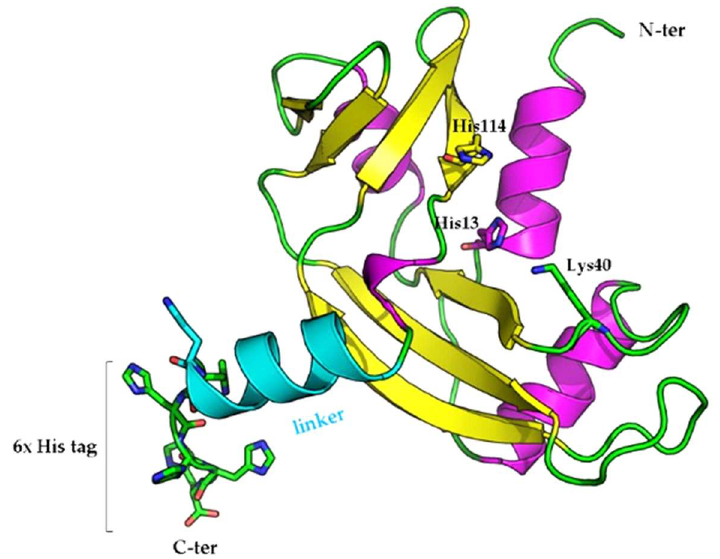
Figure 8 . Model of the variant rANG 6xHis . The linker peptide is highlighted in turquoise. Amino acids from the catalytic triad and the 6xHis tag are shown as sticks. The image was generated by the molecular visualization software PyMOL (https://pymol.org, accessed on 10 May 2022).